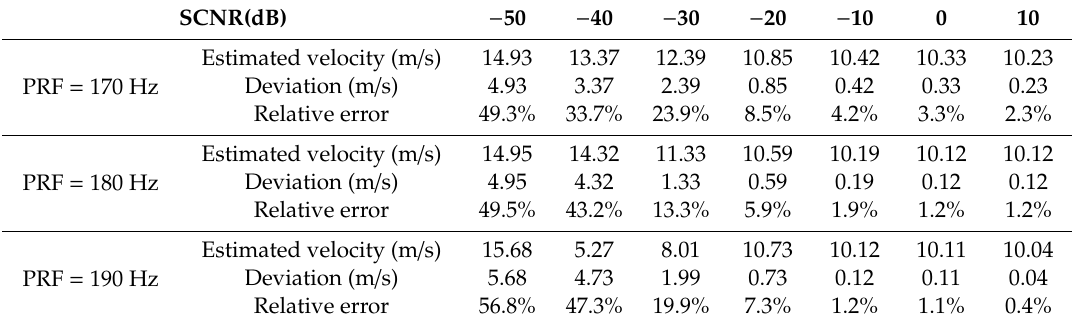
Figure 12. The introduced signal intensity ratios (SIRs) for the slant range velocity estimation. ( a ) The azimuth band-limited case. ( b ) The azimuth non-band-limited case. Table 2. Slant-range velocity estimation results with di ff erent signal-to-clutter-and-noise ratios (SCNRs). SCNR(dB) − 50